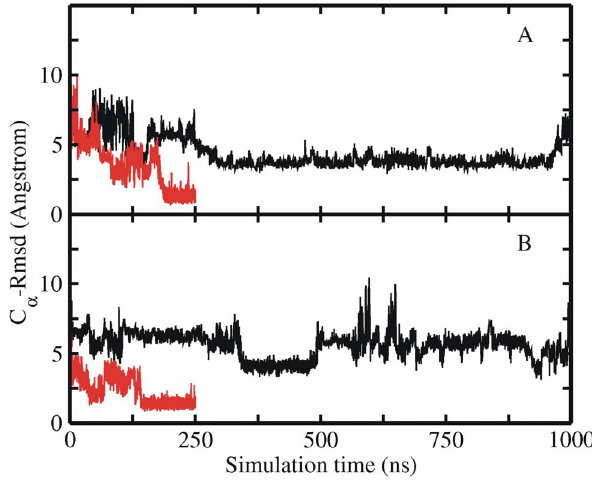
Figure 3. Free and restrained MD simulations of extended Trp- cage structure. RMSD C a of sampled Trp-cage conformations in an unrestraint explicit solvent MD simulation starting from an extended Trp-cage conformation (black line) and including dihedral angle restraints of the Trp6 residue (red line). (A) Both simulations were started from the same start structure and initial velocities employing the ff03 force field. (B) Same as in (A) but using the ff99SB force field (instead of